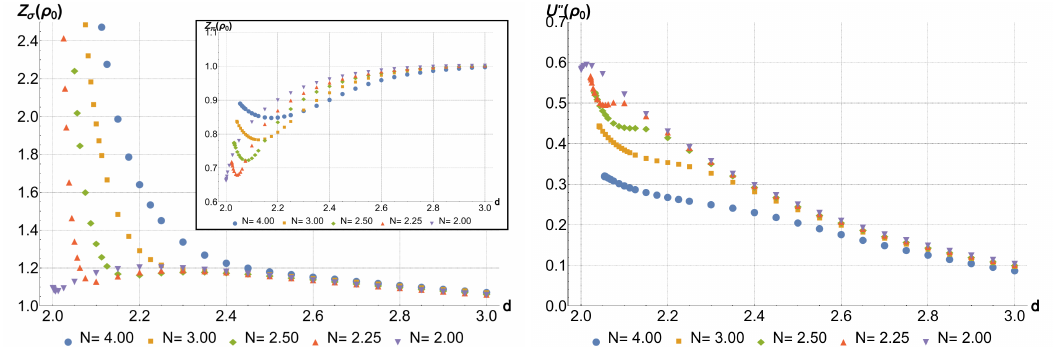
Figure 12: Critical fixed point parameters at the minimum ˜ ρ a function of d and N . The left panel shows the fluctuations suppressors: longitudinal ) (main plot) and transverse z z σ ( ˜ ρ 0 derivative of the local potential u (cid:48)(cid:48) ( ˜ ρ